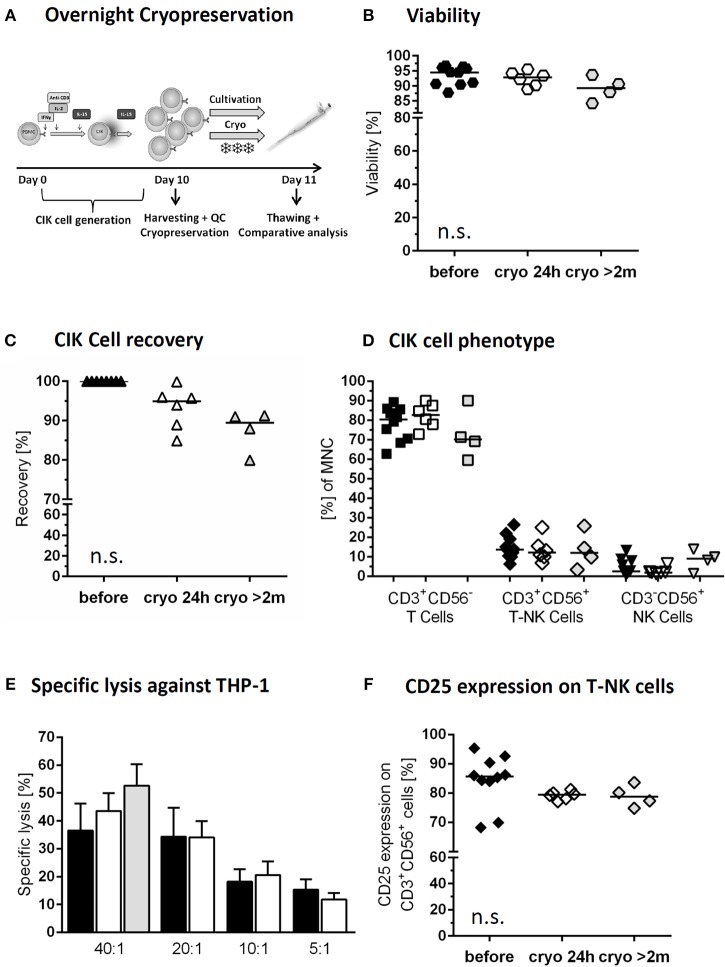
Cryopreservation of CIK cells. Comparison of freshly harvested CIK cells (black) and CIK cells following overnight cryopreservation of the same donor (white). In addition long time storage of at least 2months (median 2 years) was investigated (gray; differing donors) (A) On day 10, one part of the freshly harvested CIK cells was cryopreserved overnight, whereas a second part was further cultivated overnight. (B) Viability was slightly, but not significantly, reduced due to overnight and long-term cryopreservation. (C) CIK cell recovery was 94.9% after thawing following overnight cryopreservation an 89.5% after long-term storage. (D) The composition of CIK cells consisting of T-, T-NK- and NK-cells was not significantly influenced by overnight and long-term cryopreservation. (E) Cytotoxicity against THP-1 of CIK cells before and after cryopreservation was comparable in the tested effector/target ratios 40:1, 20:1, 10:1, and 5:1 for overnight (n = 6) and long-term cryopreservation (n = 3). (F) Independent of storage time CD25 expression on CD3+CD56+ cells minimally decreased following cryopreservation, but not statistically relevant. n = 6 experiments.